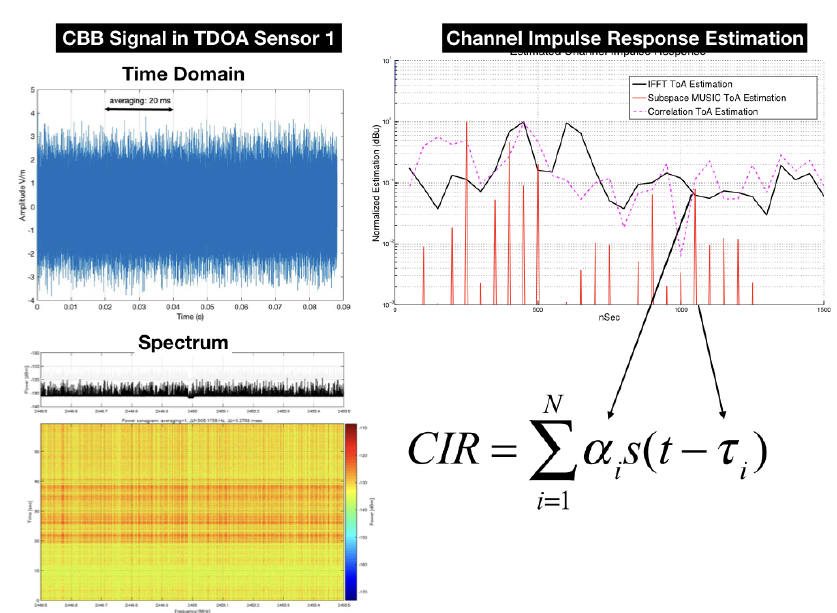
Figure 8. Channel impulse estimation in each TDOA